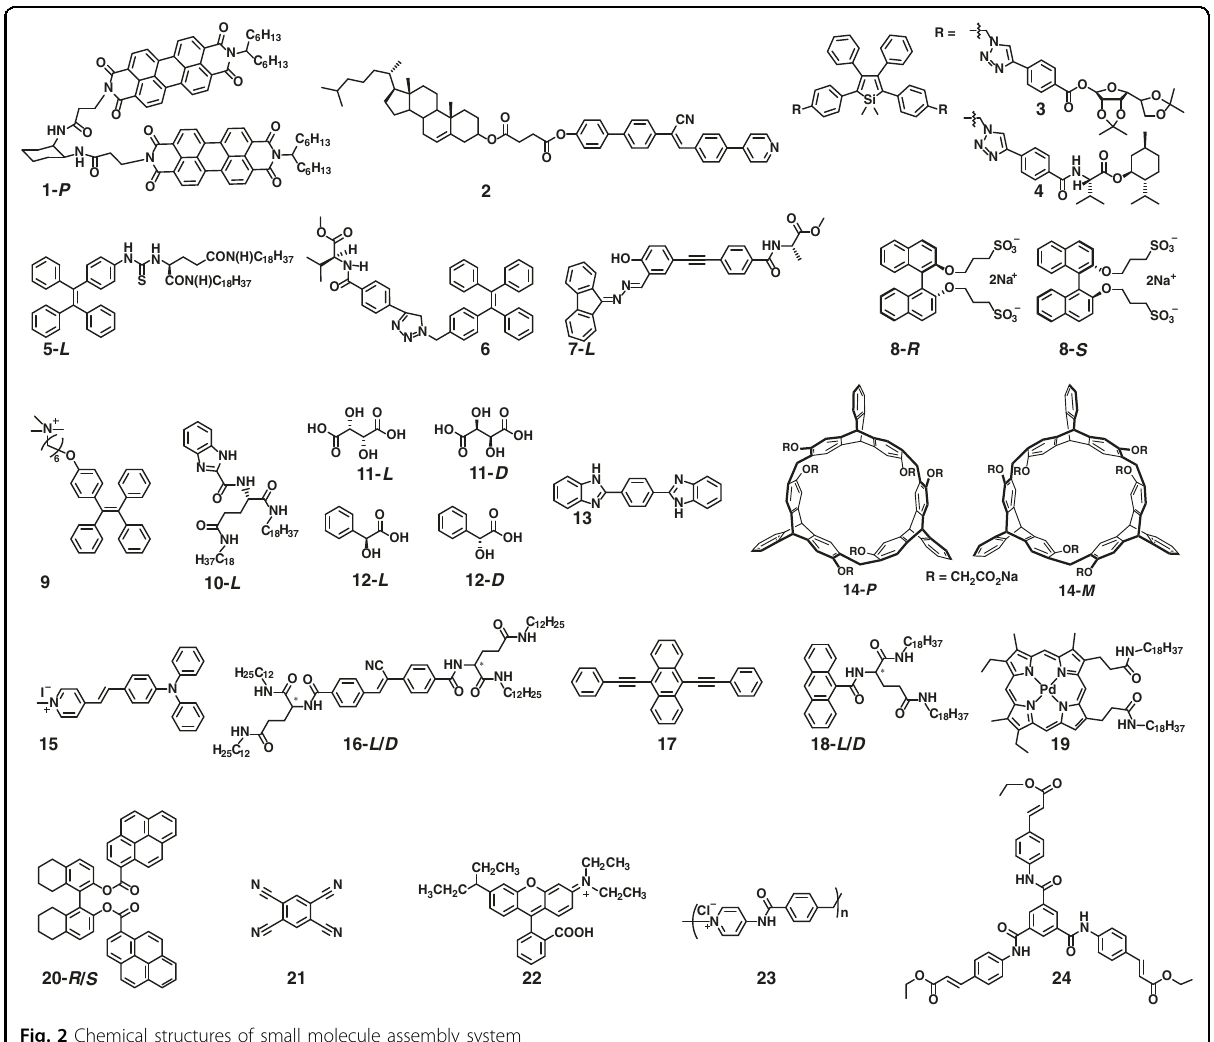
Fig. 2 Chemical structures of small molecule assembly